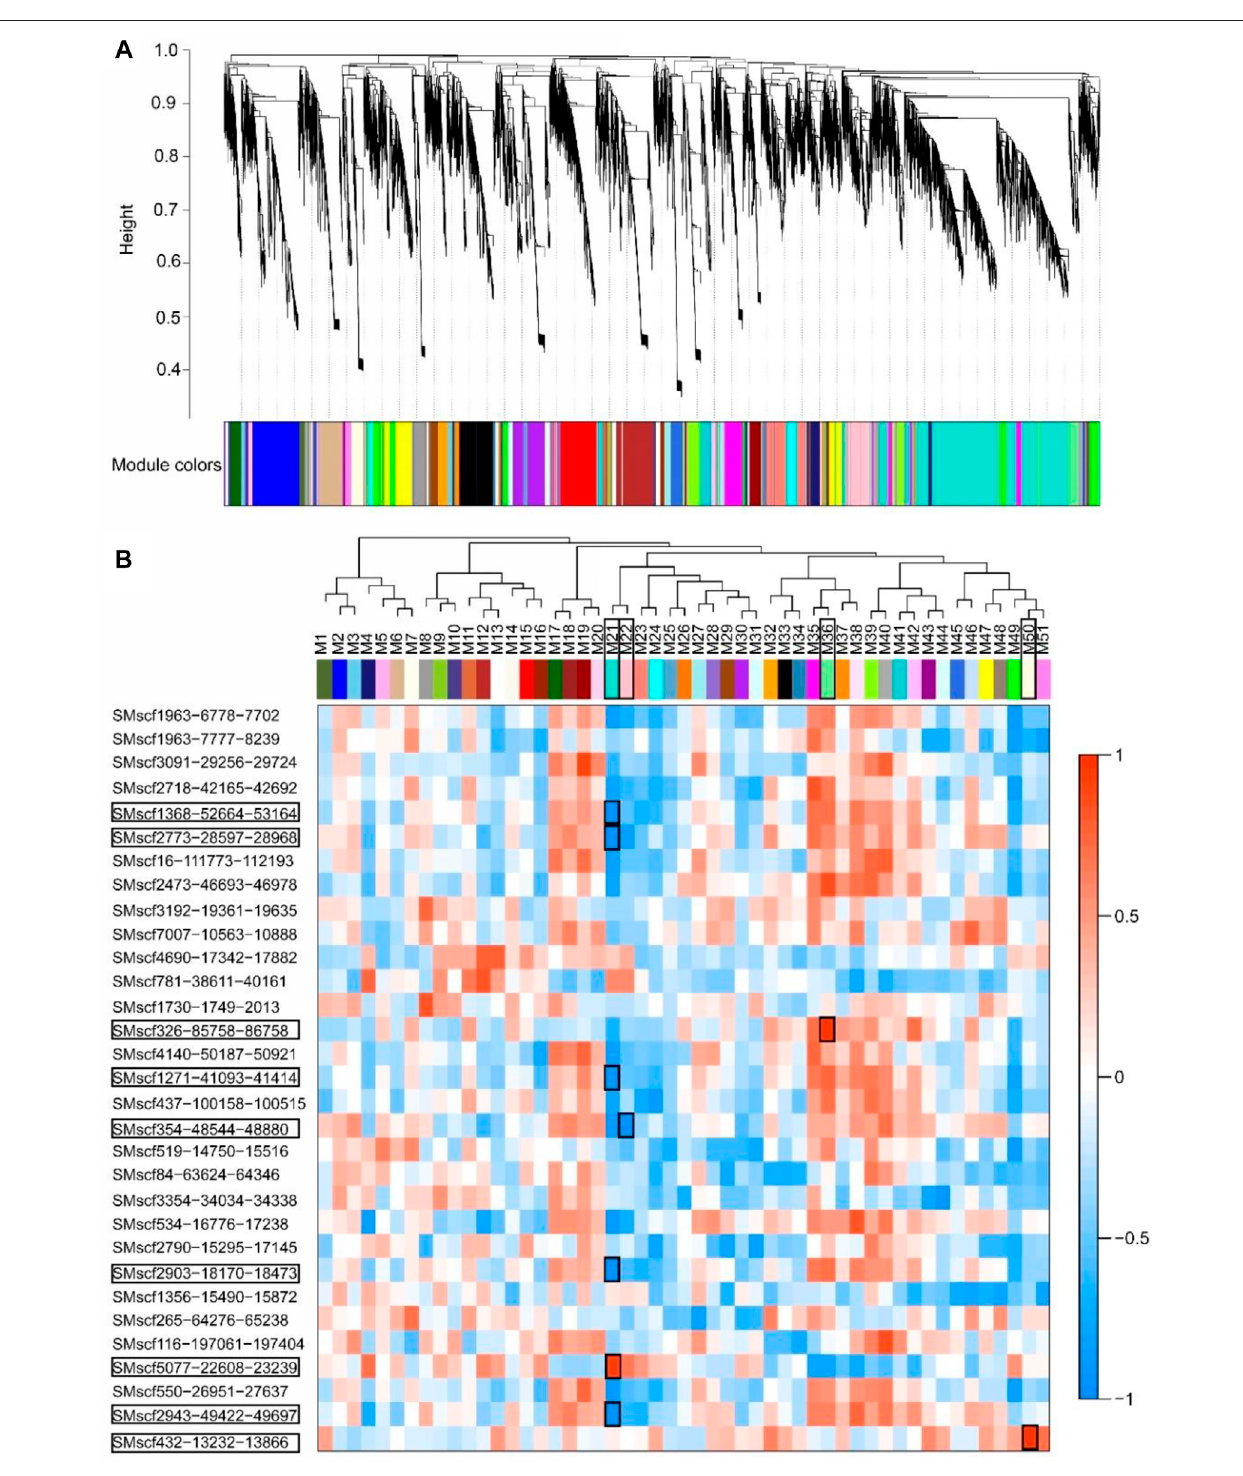
FIGURE 7 | The Co-expression analysis of 31 validated circRNAs and protein-coding genes by WGCNA method. (A) Hierarchical cluster dendrogram of modules of protein-coding genes. Modules corresponding to branches were color-coded. (B) The correlation of expression pro fi les of each module and 31 validated circRNAs. The tree showed the relationship between the modules. The heatmap showed the correlation of expression pro fi les of each module and 31 validated circRNAs. The signi fi cantly correlated circRNAs and modules were marked with black rectangles.